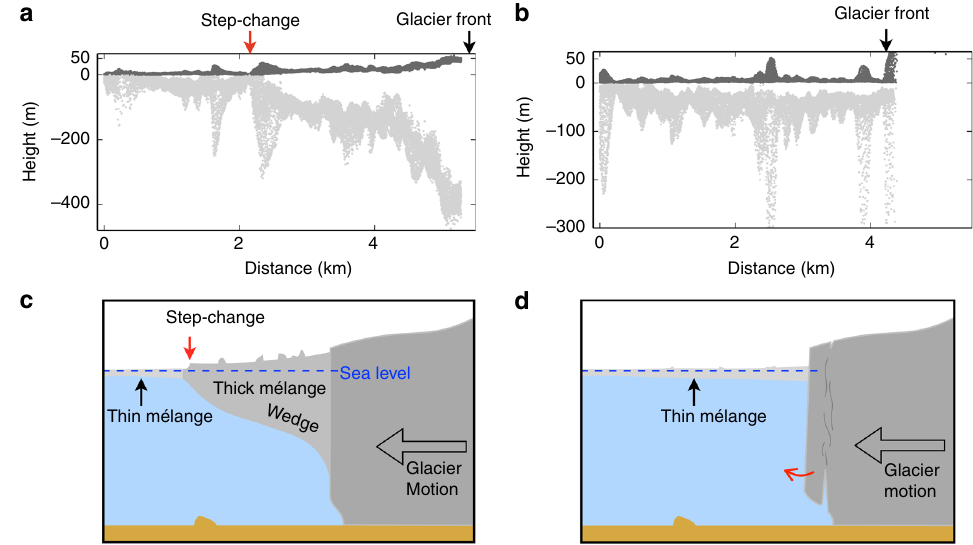
Fig. 10 Mélange wedge and its impact on glacier calving. a , b Dark and light grey correspond to surface (measured) and bottom (inferred) heights in the outlined rectangle in Fig. 7a, distance is along pro fi le from downstream. a is from this study (surface slope of the wedge is typically 0.2 – 2°) and b is from a 2015 campaign 6,17 when the mélange is relatively thin. c , d Schematic con fi gurations along fl ow section of the glacier terminus with and without the thick mélange. The thick, tapered mélange in a constrained channel buttresses the glacier front and reduces fracture propagation and